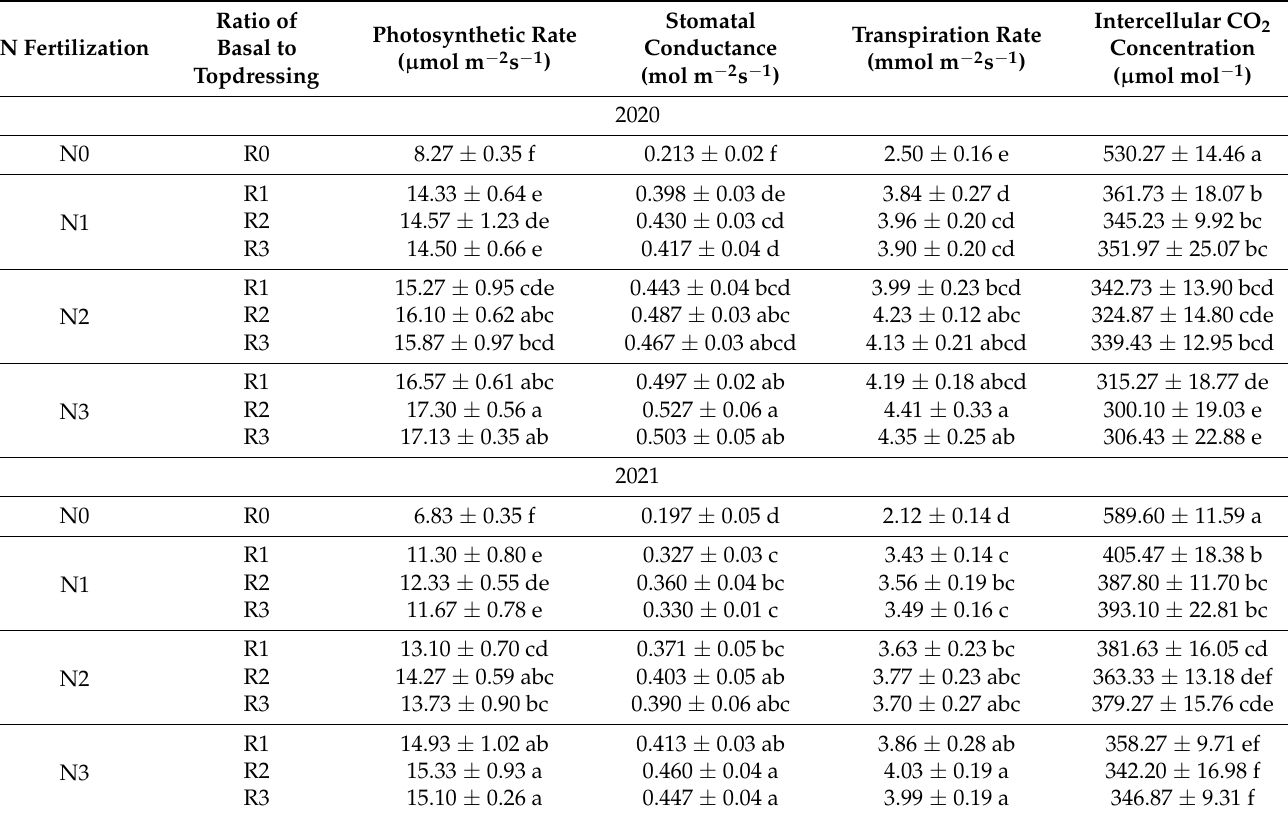
Table 2. Effects of nitrogen application method on photosynthetic characteristics of flag leaf at flowering